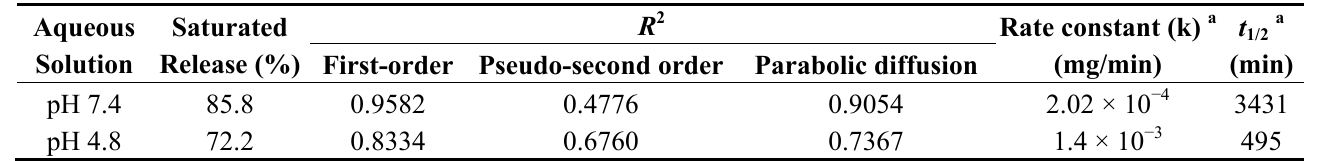
Table 2. Correlation coefficient, rate constant, and half-time obtained by fitting the release data of prindopril erbumine (PE) from iron oxide nanoparticles coated with chitosan-prindopril erbumine (FCPE) into phosphate-buffered solution at pH 7.4 and 4.8.